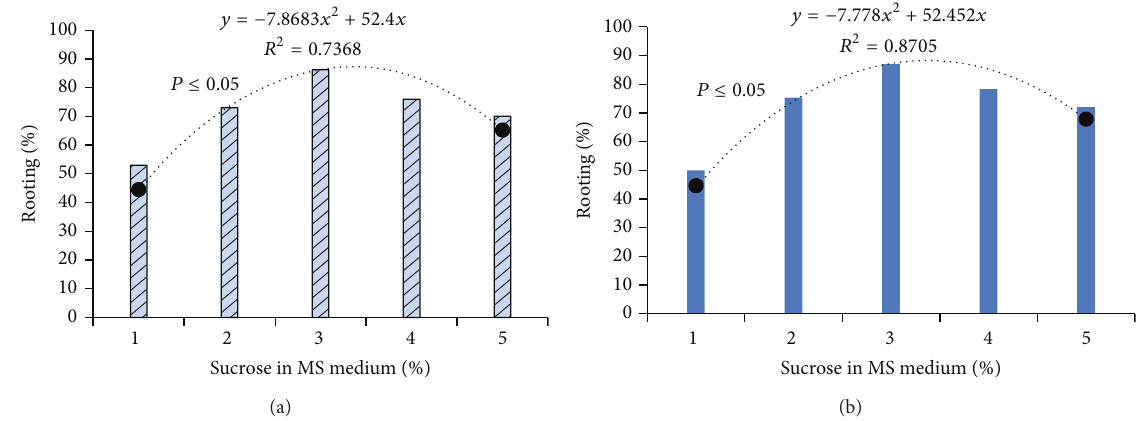
Figure 5: Effect of sucrose on rooting in MS medium revealed 3% is the optimum concentration. (a) Bambusa tulda. (b) Melocanna baccifera